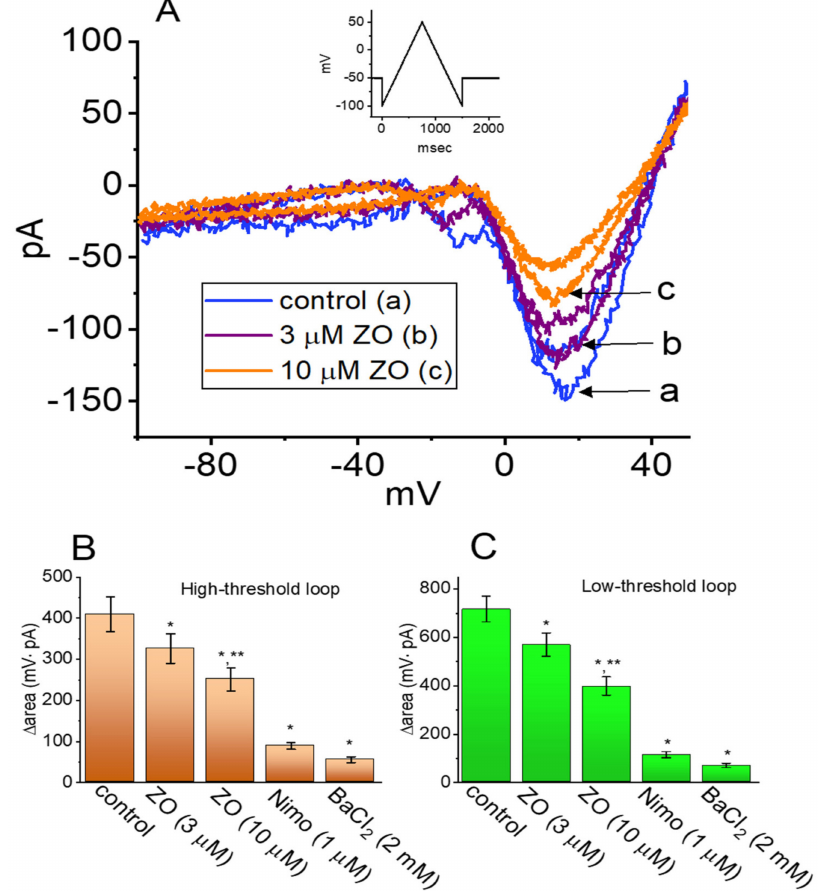
Figure 5. Inhibitory effect of ZO on I Ca,L activated by a double ramp pulse in GH 3 cells. ( A ) Representative current traces obtained in the control period (a) and in the presence of 3 µ M ZO (b) or 10 µ M ZO (c). The inset in the upper part illustrates the voltage protocol. ( B , C ), respectively, illustrate the effects of ZO (3 and 10 µ M) or BaCl 2 replacement on the hysteretic area (high- and low-threshold loop) of I Ca,L (mean ± SEM; n = 7 for each bar). * Significantly different from the controls ( p < 0.05) and ** significantly different from the ZO (3 µ M)-alone groups ( p < 0.05). Panel ( A ): (One-way ANOVA, F(4,30) = 4.156, p = 0.01) and panel ( B ): (One-way ANOVA, F(4,30) = 3.692, p =